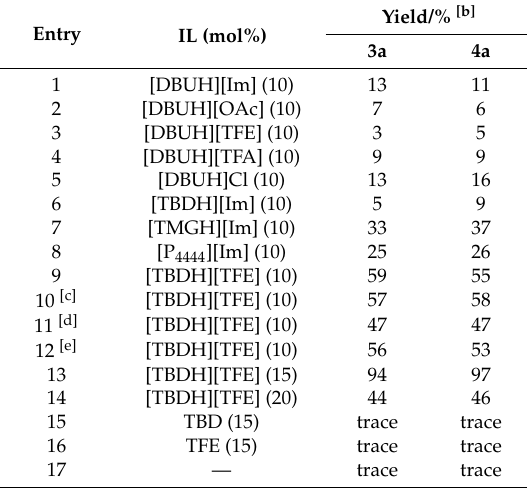
Table 2. Optimization of the reaction conditions [a] .